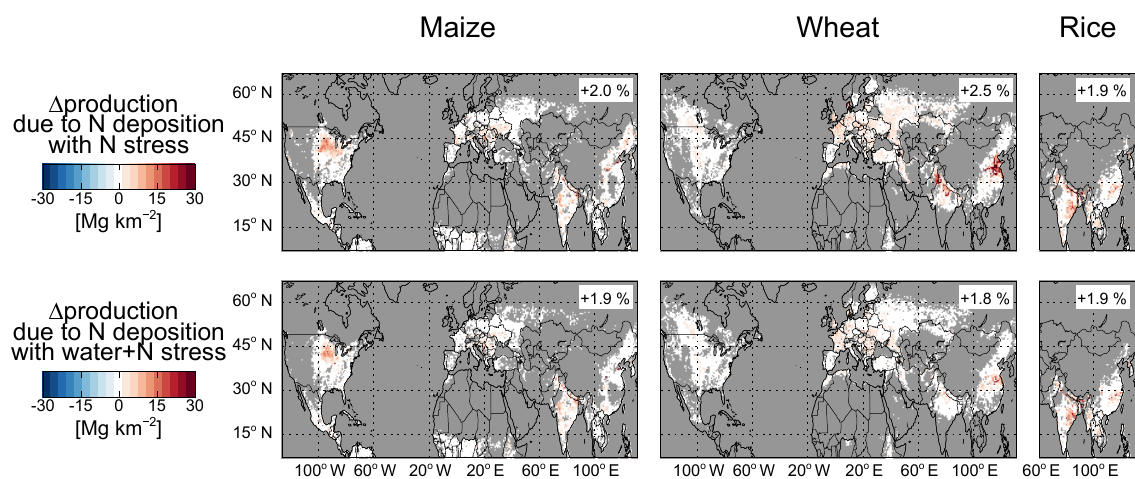
Figure 7. Change in pDSSAT crop production due to nitrogen (N) deposition with N stress (top row panels) and water and N stresses (bottom row panels) applied. For growing season ending in 2010 for maize (left column panels), wheat (middle column panels), and rice (right column panels). Filtered for GAEZ base crop production greater than 0.01Mgkm − 2 . Global relative production change shown in upper right of each